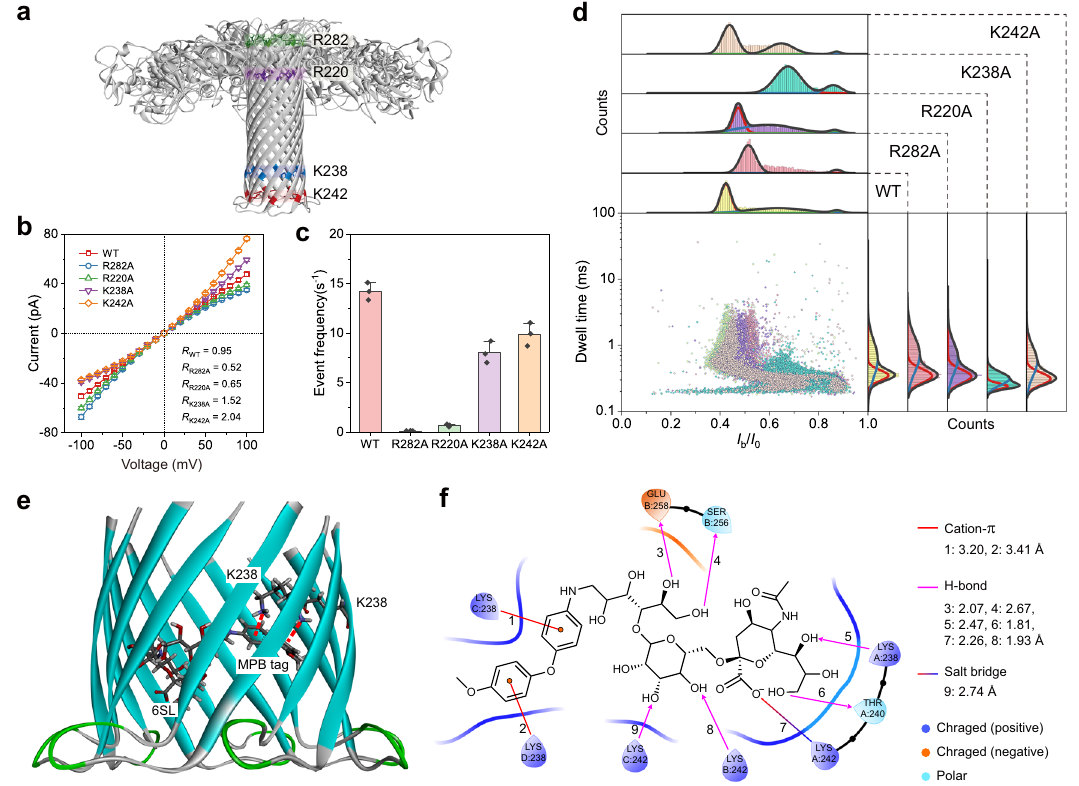
Fig. 4 | Molecular mechanism of nanopore blockage. a WT AeL model (PDB: “ 5JZT ” )andfourresidueringsmarkedwithstickmodelsanddifferentcolors. b , I – V curvesofWTAeLandmutants(R282A,R220A,K238A,andK242A),whereeachdata point represents the mean±SD of three independent experiments. Insets are rec- ti fi cation ratios ( R ) ( ǀ I +100 mV / I − 100 mV ǀ ). c Event frequency of WT AeL and mutants from 6SL-MPB with the same fi nal concentration (2 μ M). Data are presented as bar charts with mean values of frequency ± SD of three independent experiments. Individual data points are shown as black dots. d Scatter plots and the corre- sponding I b / I 0 and dwelltimedistributionsof6SL-MPBmeasured withWTAeLand